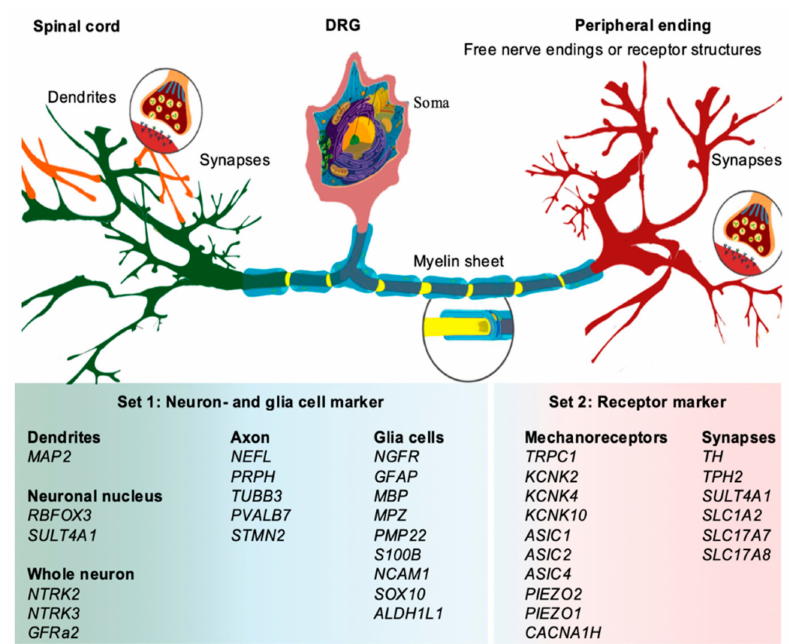
Figure 1. The pseudo-unipolar dorsal root ganglion (DRG) of a vertebrate neuron cell. Dendrites and synaptic connections within the spinal cord ( green ) are shown on the left side. The soma ( pink ) lies within the DRG beside the spinal colon. The axon ( yellow ) connects dendrites and soma to the peripheral ending ( red ) where the axon ramifies into free nerve endings or builds up receptor structures like Merkel, Ru ffi ni, Meissner, or Pacinian corpuscles. The signal transmission between the peripheral ending and receptor structures is similar to synapses, which use equal neurotransmitters. The axon can be enveloped by myelinating Schwann cells ( turquoise ). The panel of genes selected for the present study and the expected site of translation are listed below the illustration. The graph is based on a free illustration (Wikipedia) by Mariana Ruiz